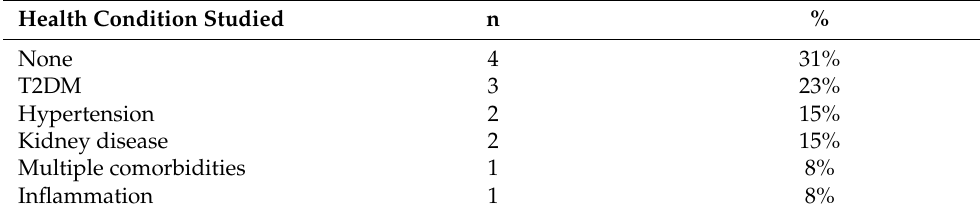
Table 4. Category 1, 2 & 3 studies by health condition studied.